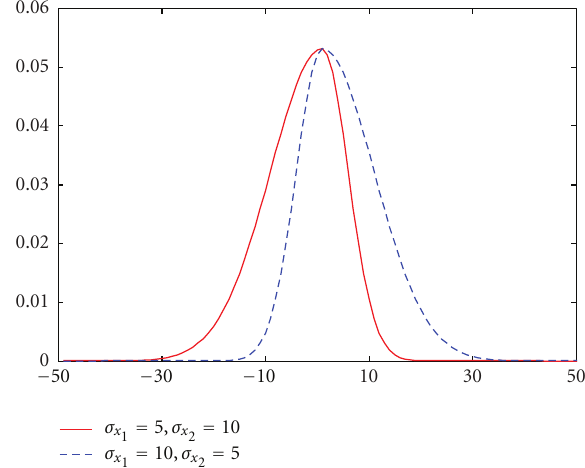
Figure 1: Distribution of f ( x t ) with zero mean and two variant variances.